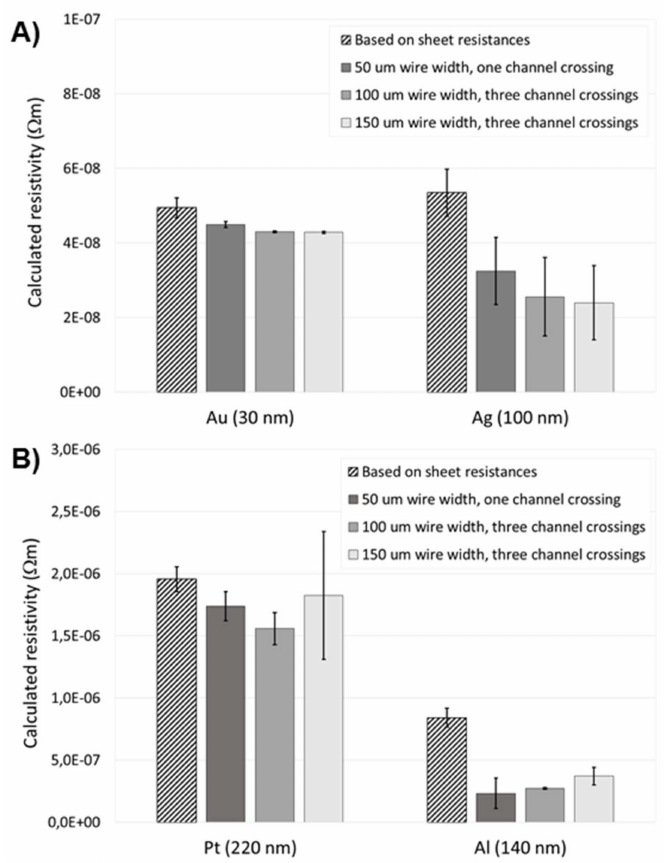
Figure 4. The resistivities of ( A ) Au and Ag metallizations and ( B ) Pt and Al metallizations calculated based on both measured sheet resistances of planar metal films and measured resistances of the metal wires (of di ff erent widths) travelling across the edges of Ormocomp microchannels one or three